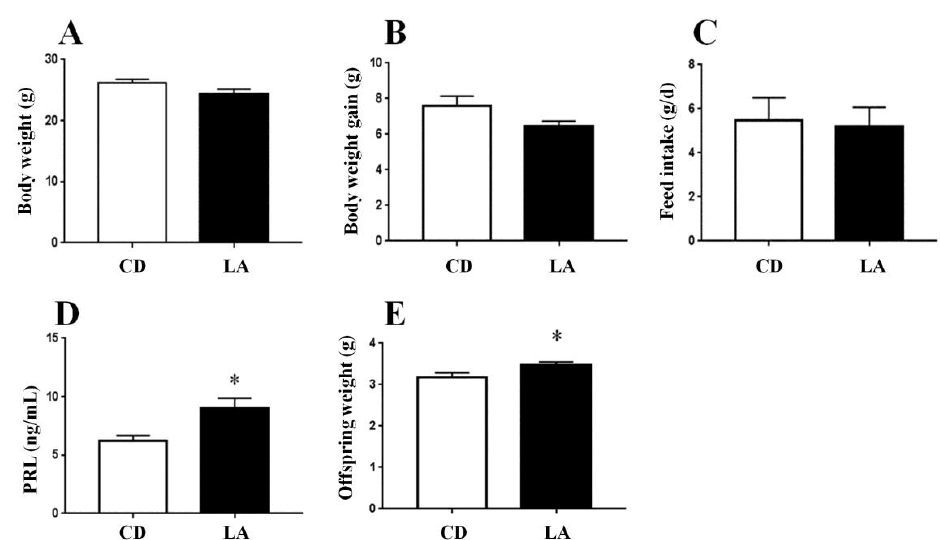
Figure 1. The effects of dietary supplementation of 1% lauric acid (LA) on lactating female mice and offspring mice. ( A ) The dietary 1% LA on the body weight of lactating mice. ( B ) The body weight gain of lactating mice. ( C ) The daily feed intake of lactating mice. ( D ) The content of PRL in the serum of lactating mice. ( E ) The average weight of offspring mice (n = 6). CD is control group. * p < 0.05 versus control group.